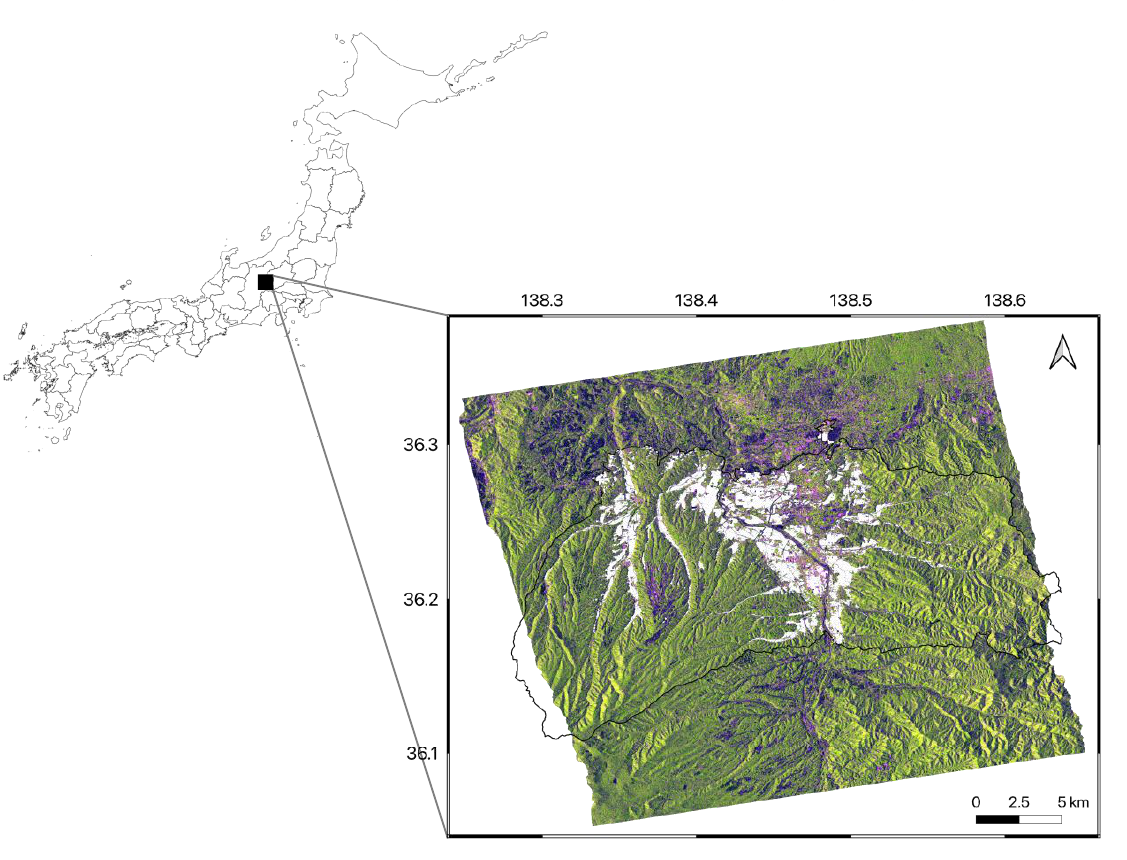
Figure 1. A rice paddy field in Saku city, Nagano Prefecture, Japan, was employed as the study area. White lines show the paddy field; the background image is a color composite of Sentinel-1 data (R: VV, G: VH, B: VV/VH).